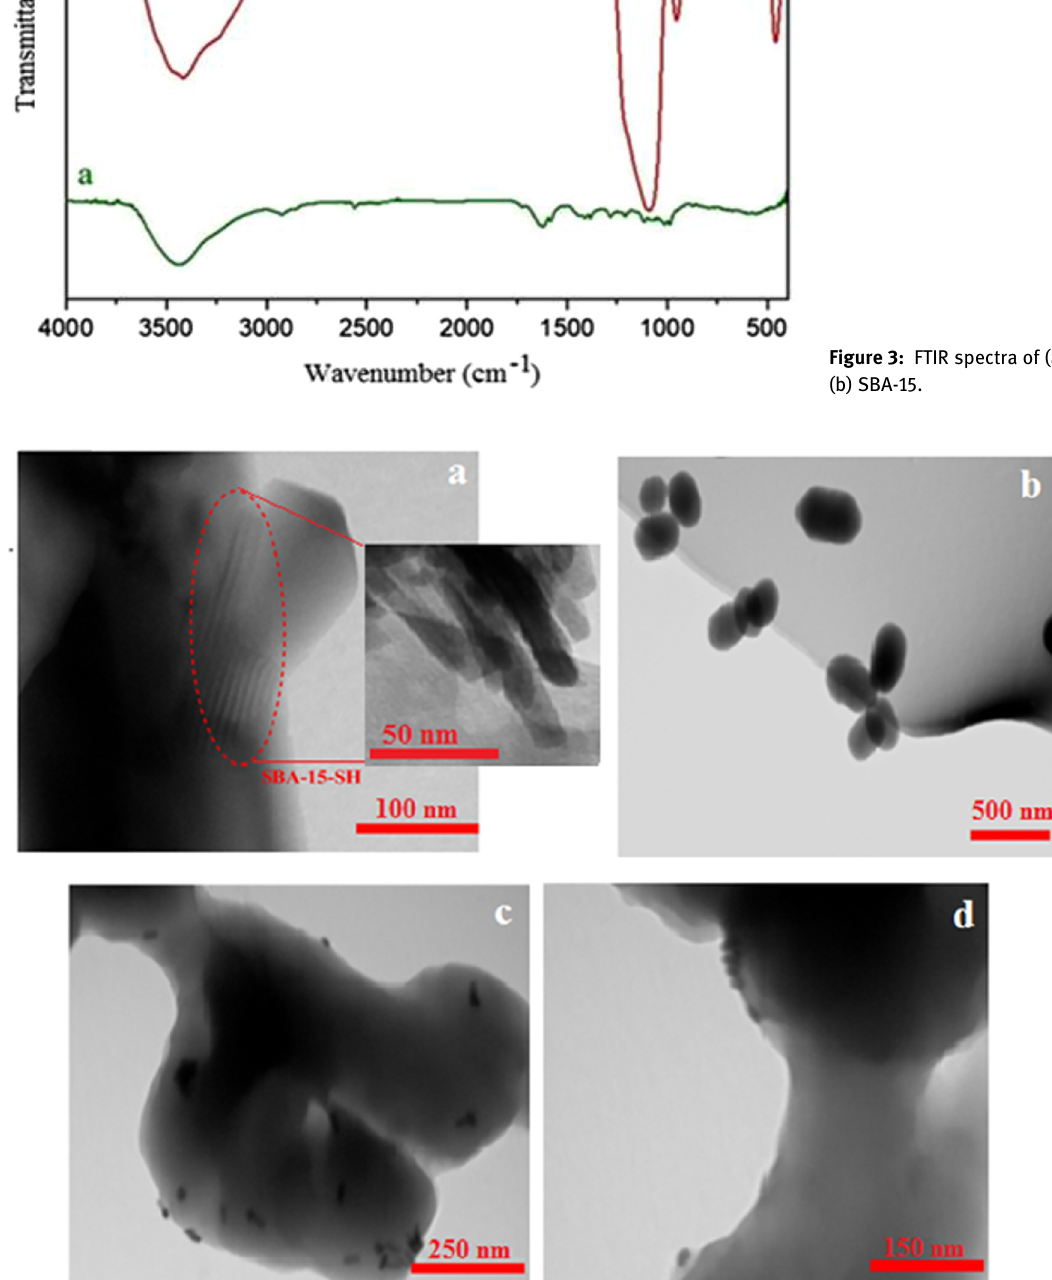
Figure 4: TEM images of (a) SBA-15-SH, (b) GNRs@SBA-15-SH, and (c), (d) GNRs@SBA-15-SH/DOX,